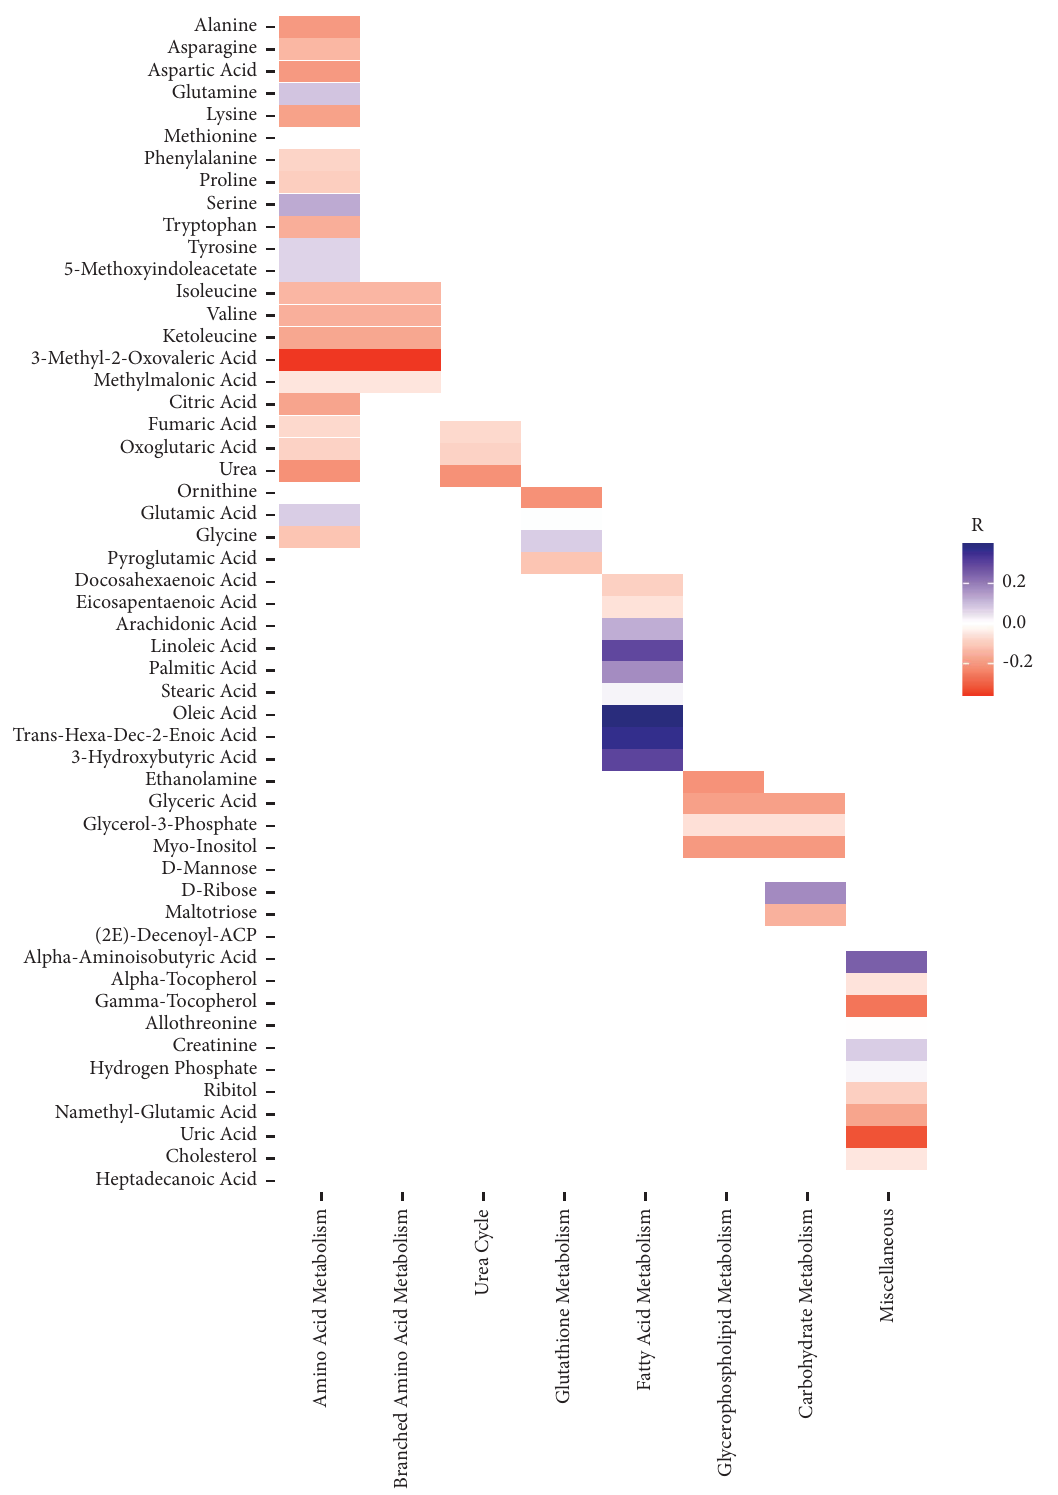
Figure 1: Correlation table. Abundance of each metabolite was defned based on mass spectral peaks. Te table shows the correlation between body fat mass and abundance of 53 metabolites identifed by an untargeted